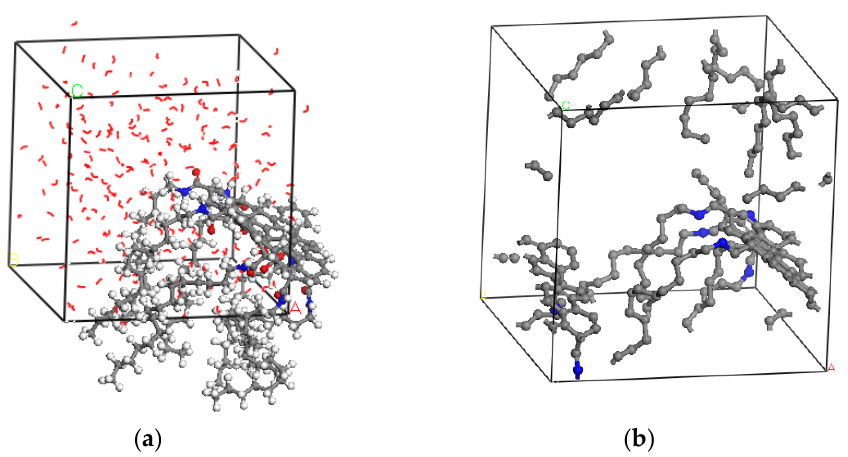
Figure 5. Schematic diagram of the initial model: ( a ) Dispersed morphology, ( b ) NGO distribu- tion.